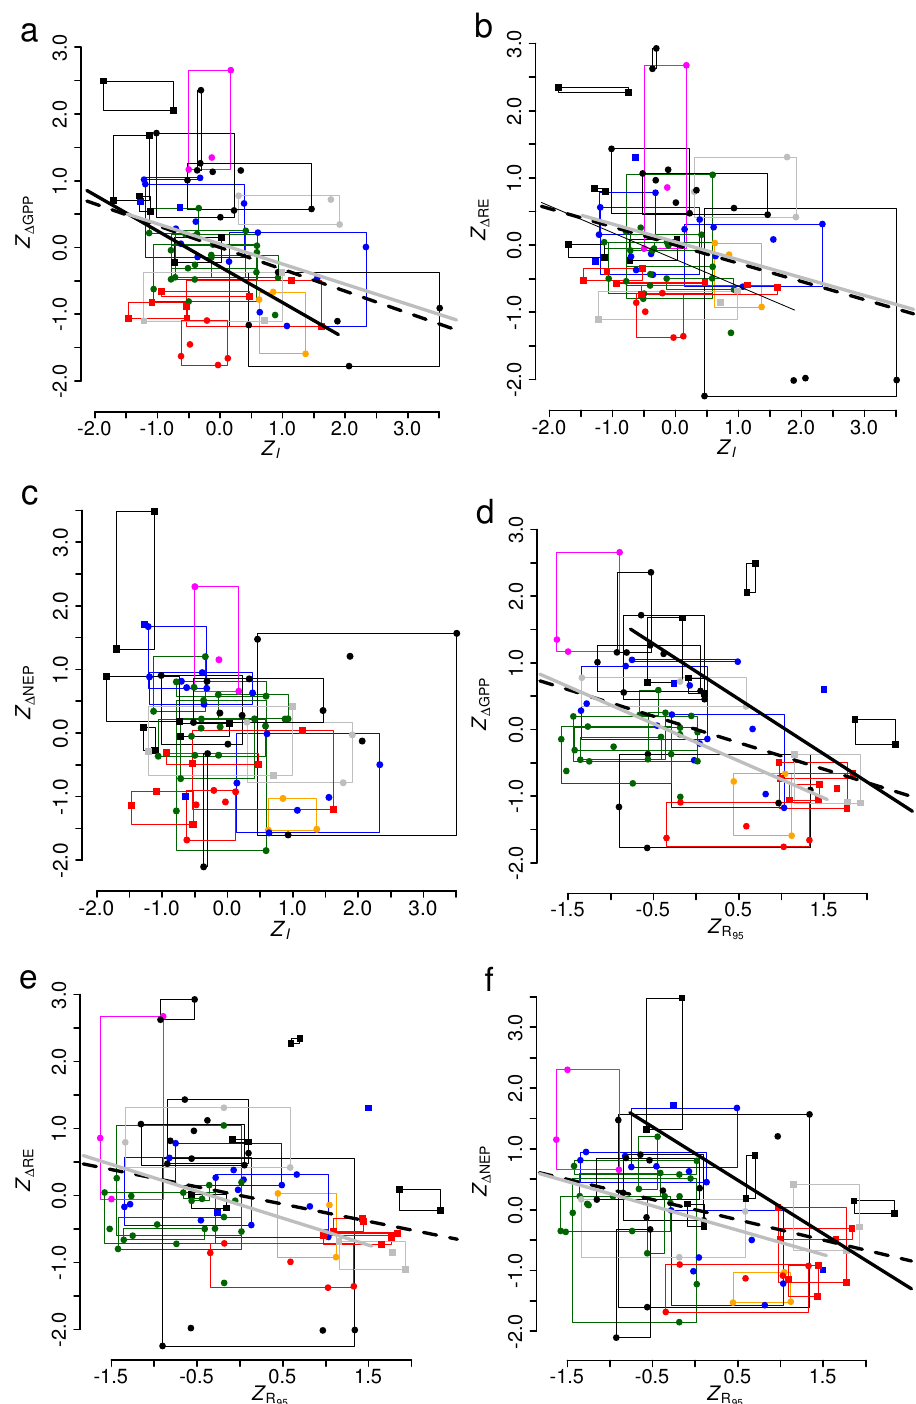
Fig. 3. Standardised annual ecosystem flux residuals ( Z 1 GPP , Z 1 RE and Z 1 NEP ) versus Z I (a, b, c) and Z R represents a single site-year (“dry” sites as squares, “wet” as circles, colour-coded by the IGBP ecosystem type: grey – CSH, green – DBF, blue – EBF, black – ENF, magenta – MF, orange – SAV, red – WSA). Lines show linear regressions significantly different from zero at the 5% (thick lines) or 10% (thin lines) level, solid lines for the “dry” (black) and “wet” (grey) groups separately and dashed lines for the whole data set. Rectangles cover the range of interannual variability for each